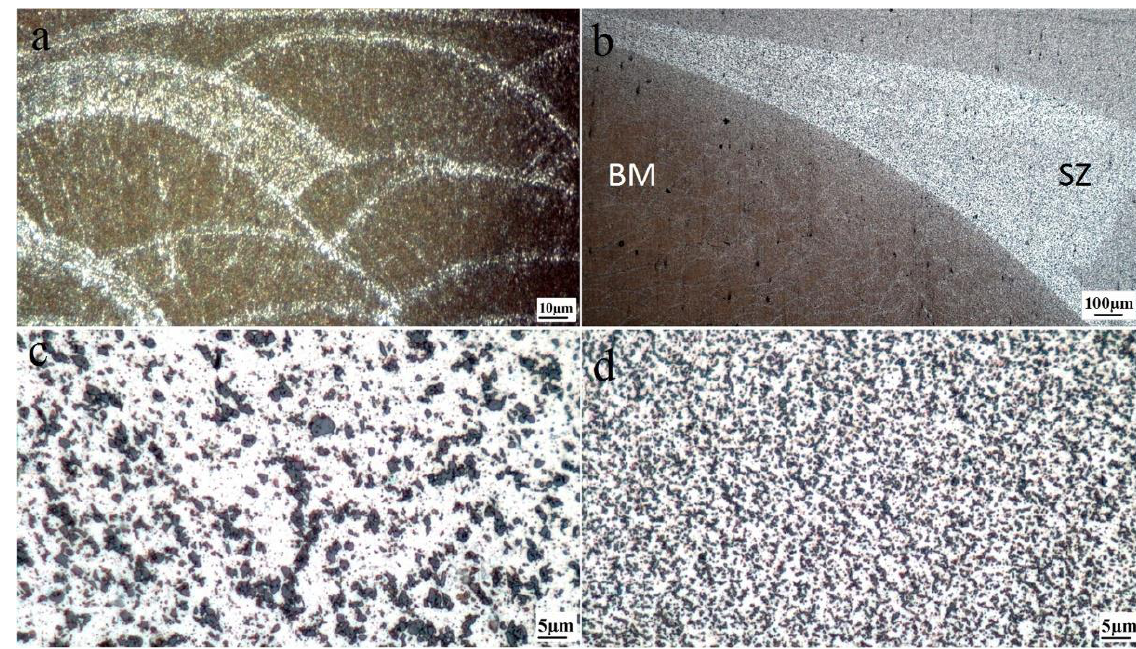
Figure 3. Optical microscopy images showing typical microstructural zones S1: ( a ) BM, ( b ) transi- tion zone between SZ and BM including TMAZ and HAZ, ( c ) coarse SZ, and ( d ) fine SZ. The fine and coarse SZ refer to the zones with fine and coarse Si particles.